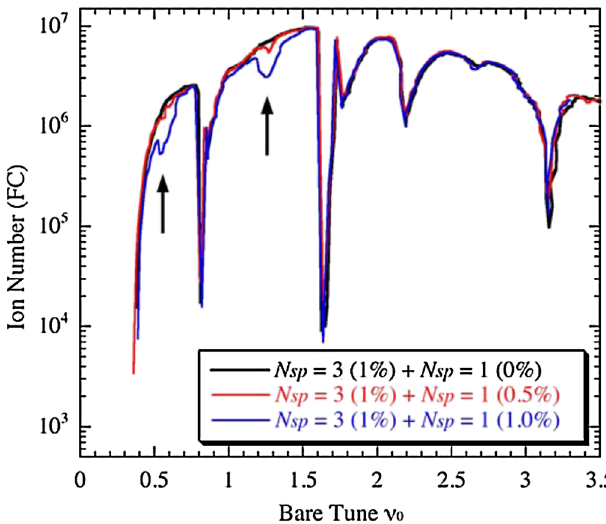
FIG. 10. (Color) Experimental results in the high-density regime where an N sp ¼ 1 perturbation has been applied in addition to the lattice-induced wave of N sp ¼ 3 . The amplitudes of the imperfection waves ( N sp ¼ 1 ) are 0%, 0.5%, and 1% of the primary N sp ¼ 12 focusing wave. The amplitude of the N sp ¼ 3 wave is 1% of the primary wave in all three cases. The plasma storage time is 1